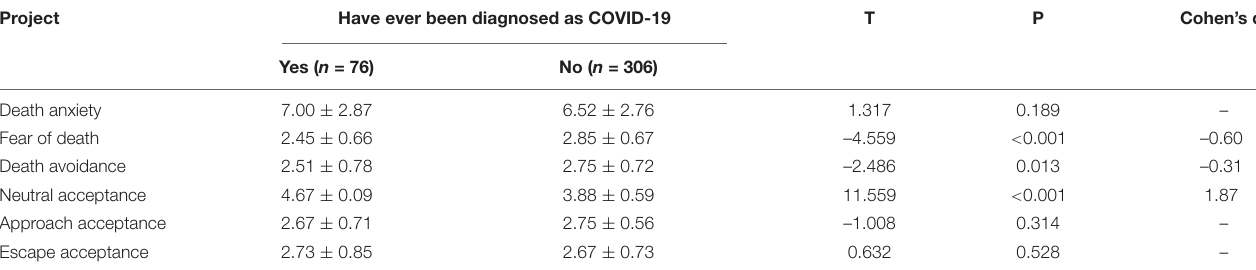
TABLE 7 | Results of death attitude and anxiety in significant persons (family member/friend/colleague/neighbor) have ever been diagnosed with COVID-19.